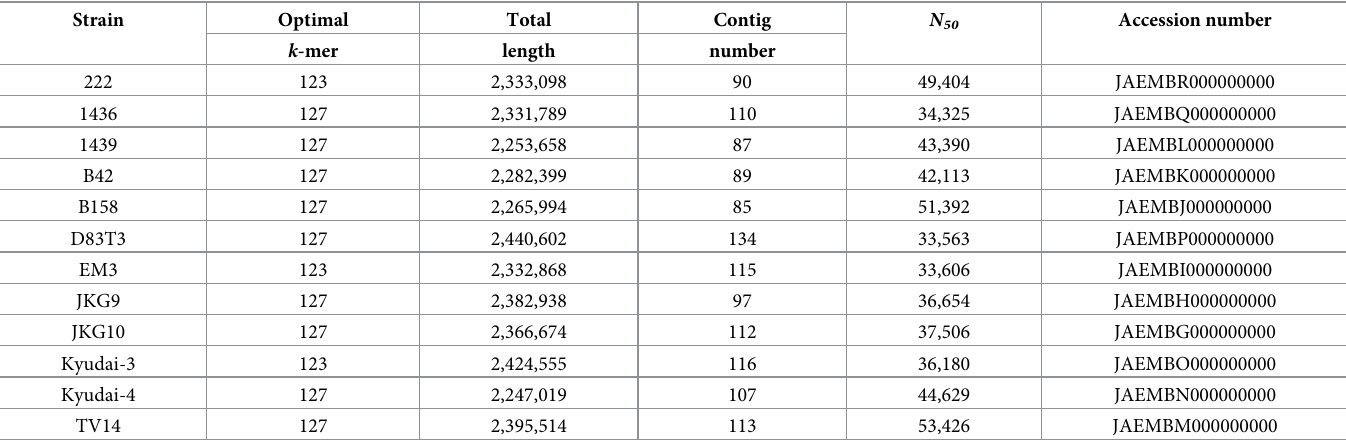
Table 1. Basic information of genome-sequencing of 12 strains in this study.